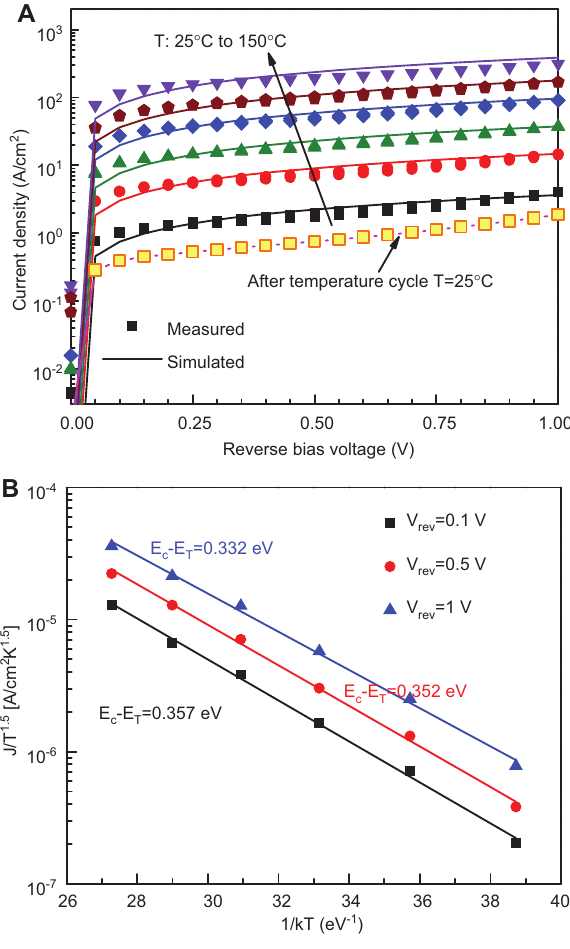
Figure 37 (A) Measured and simulated I-V characteristics of the reverse-biased GaAs Sb /In Ga As p + -i-n + diode with tempera- 0.35 0.65 0.7 0.3 tures ranging from 25 ° C to 150 ° C and (B) an extraction of activation energy for leakage current. Activation energy was between E In Ga As and GaAs Sb , indicating that SRH G-R from both 0.7 0.3 0.35 0.65 mid-gap interface traps and mid-gap bulk traps dominate the OFF- state transport of the TFET devices. Reprinted from Ref. [24], with permission, from